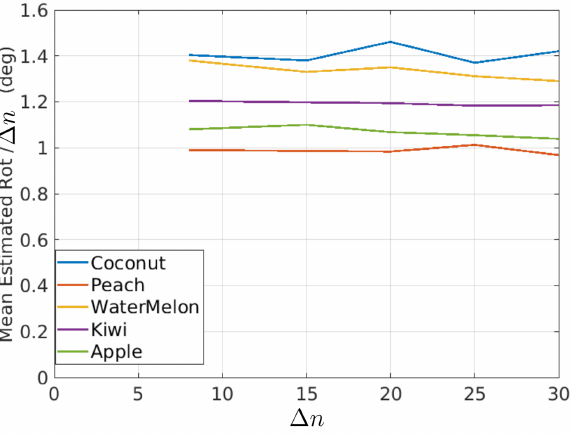
Figure 22. Mean rotation speed as a function of ∆ n for different fruit types. Table 2. Mean rotation speed for different values of ∆ n and fruit type. Data corresponding to curves of Figure 22. Coconut